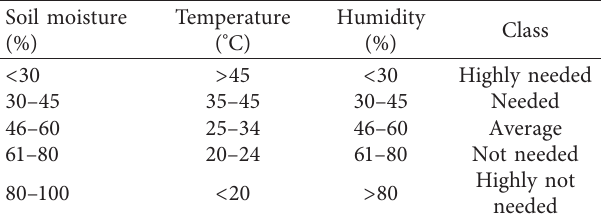
Table 2: Classes of sensor